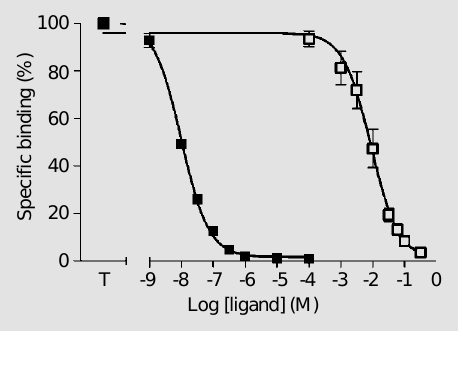
Figure 2. Cumulative concentra- tion-response curves (1-h inter- val) for trimethylsulfonium in rat jejunum, in the absence (filled squares, N = 9) and in the pres- ence of 1 nM atropine (circles, N = 7), 10 nM atropine (open squares, N = 8) and 100 nM atro- pine (inverted triangles, N = 5). The antagonist was applied 1 h before the agonist. Data are re- ported as means ± SEM.